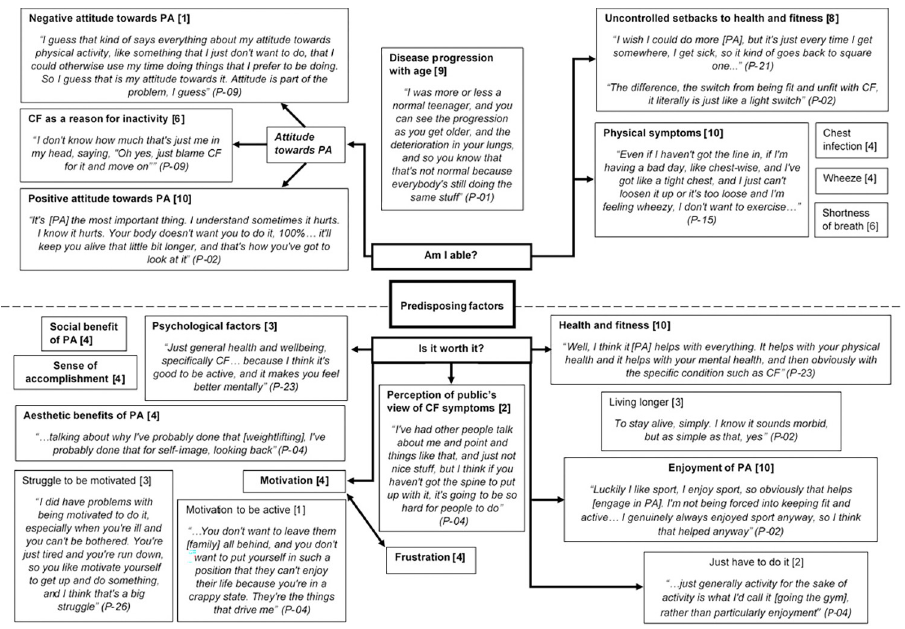
Fig 3. Pen profile displaying predisposing factors (n = 11) with illustrative quotes, associated participant number and frequency count provided in square brackets.